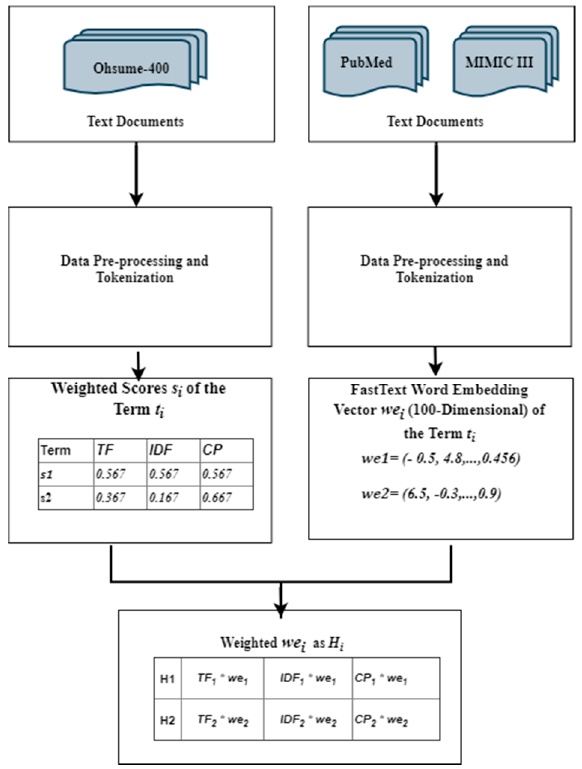
Figure 1. The steps of the weighted feature representation.